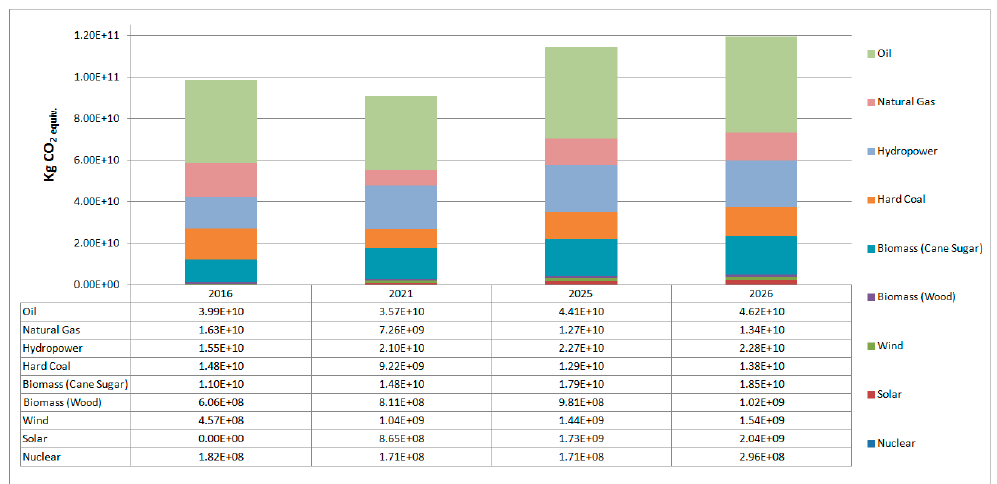
Figure 4. This figure reveals the potential of absolute impact in the electricity generation in Brazil (2016–2026) in terms of